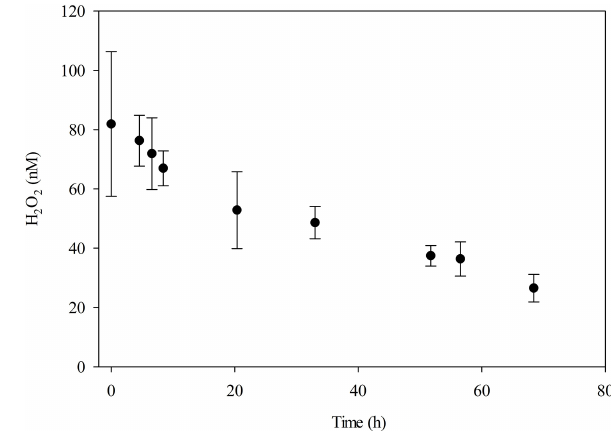
Figure 3. Seawater from MesoMed (without macronutrient, DOC or zooplankton amendment) was used to fill a 20L HDPE container, which was then incubated under the synthetic lighting used in the MultiMed experiment for 72h with regular subsampling for analy- sis of H 2 O 2 ( ±